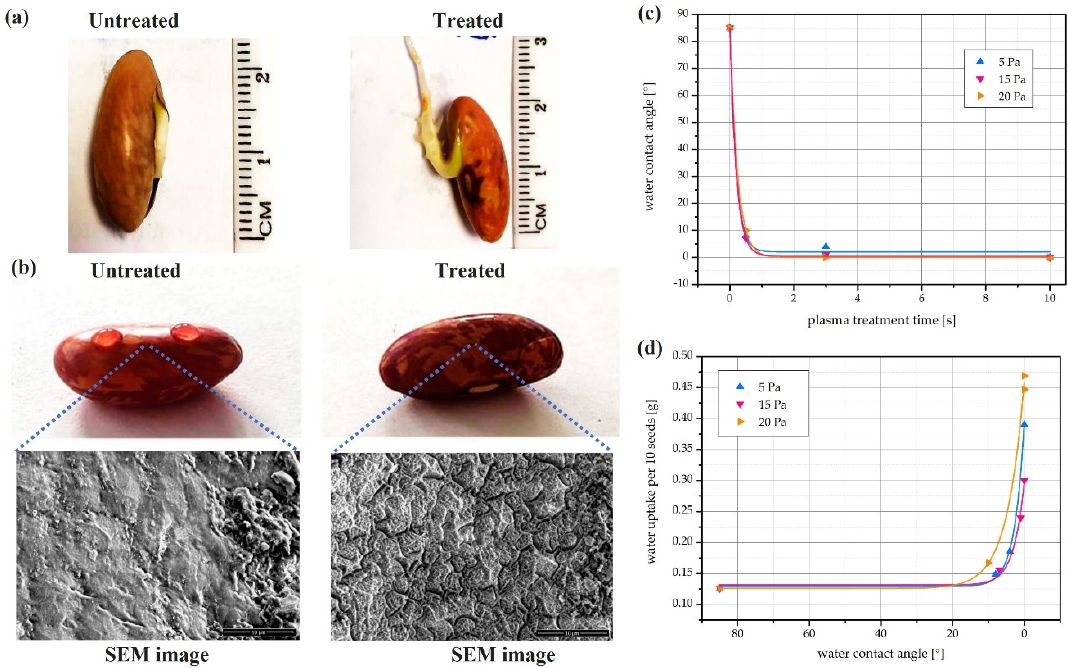
Figure 6. CAP treatment improved the water uptake of bean seeds. ( a ) Visual bean seed radicle length after 4 days of incubation. ( b ) Water droplets on untreated and treated bean seed. SEM images of seeds’ surface were shown below. ( c ) The effect of plasma treatment on water contact angle on seed’s surfaces. ( d ) The effect of plasma treatment on water uptake of seeds [109].